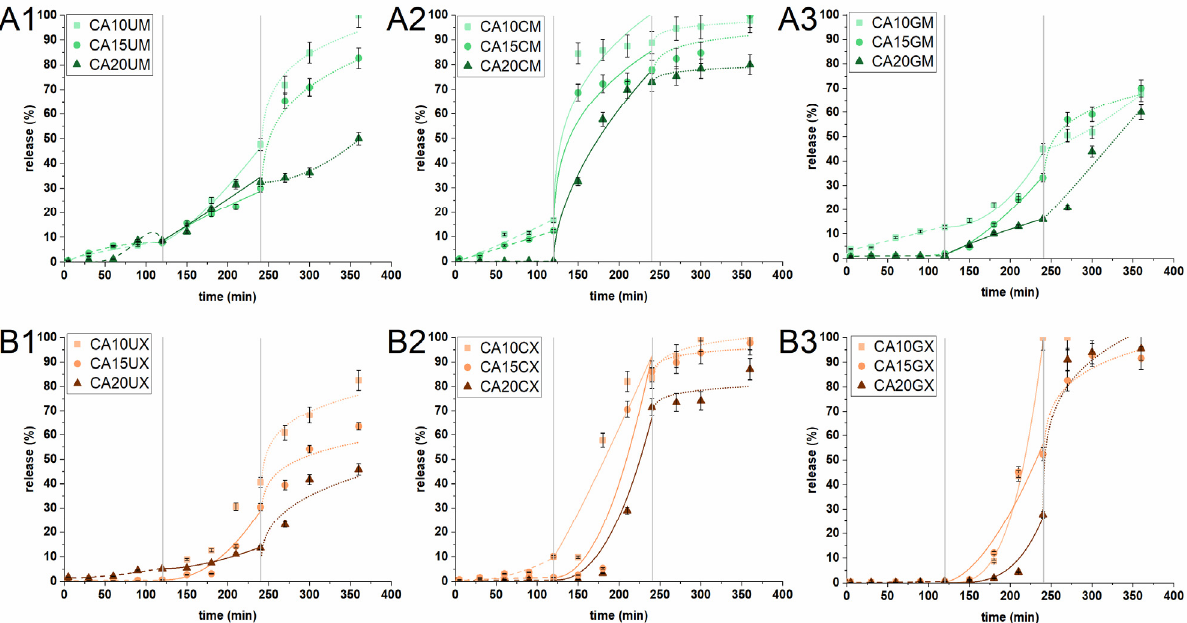
Figure 5. In vitro cumulative release profiles of CUR from ( A1 ) uncoated microparticles, ( A2 ) CHIT-coated microparticles, ( A3 ) GEL-coated microparticles, ( B1 ) uncoated macroparticles, ( B2 ) CHIT-coated macroparticles, and ( B3 ) GEL-coated macroparticles under conditions simulating the stomach (0–120 min) (SGF), intestines (121–240 min) (SIF) and colon (241–360 min) (SCF). Lines correspond to CUR release profiles that best fit the selected kinetic models: dashed in SGF, solid in SIF, dotted for SCF (see Table 1 for details of the particle composition). The results are presented as the means ± S.D.